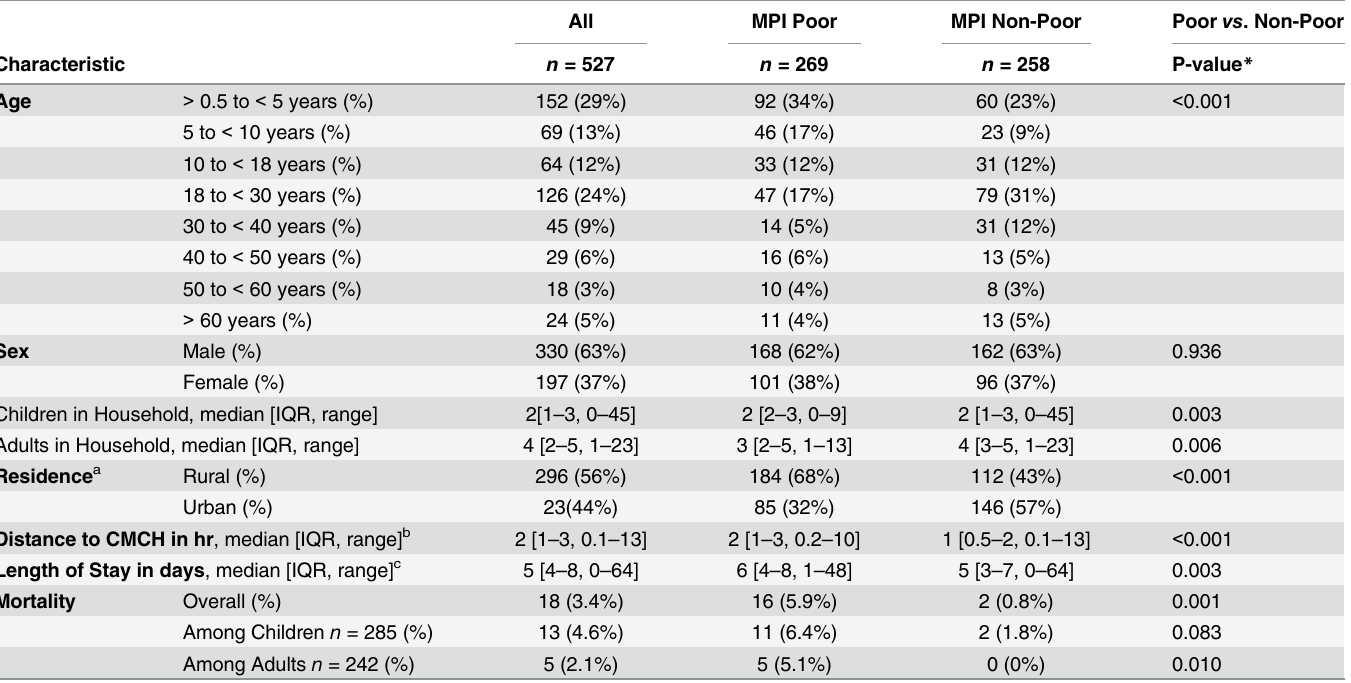
Table 1. Baseline characteristics of participants and